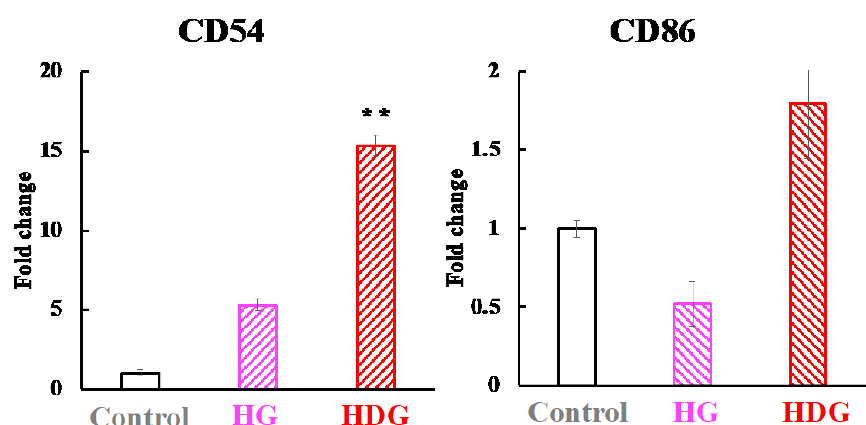
Figure 10. CD54 and CD86 mRNA expression levels in THP-1 cells after HDG or HG exposure in the h-CLAT method. The value with two asterisks is significantly different from that of the DW group at p < 0.01 by the Tukey test. Each value is the mean of four experiments, with SE shown as a vertical bar.